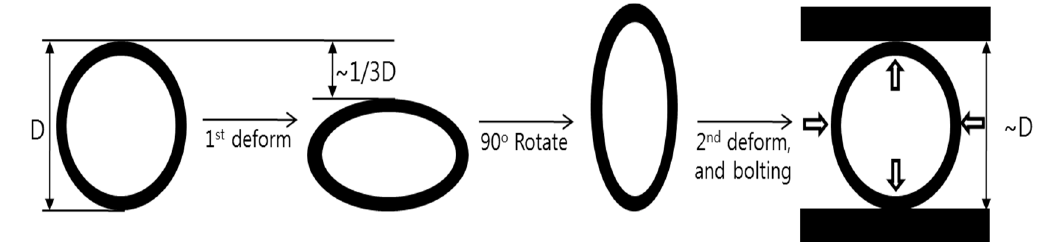
Figure 2. Fabrication process of ovalized tube (OT) specimen.